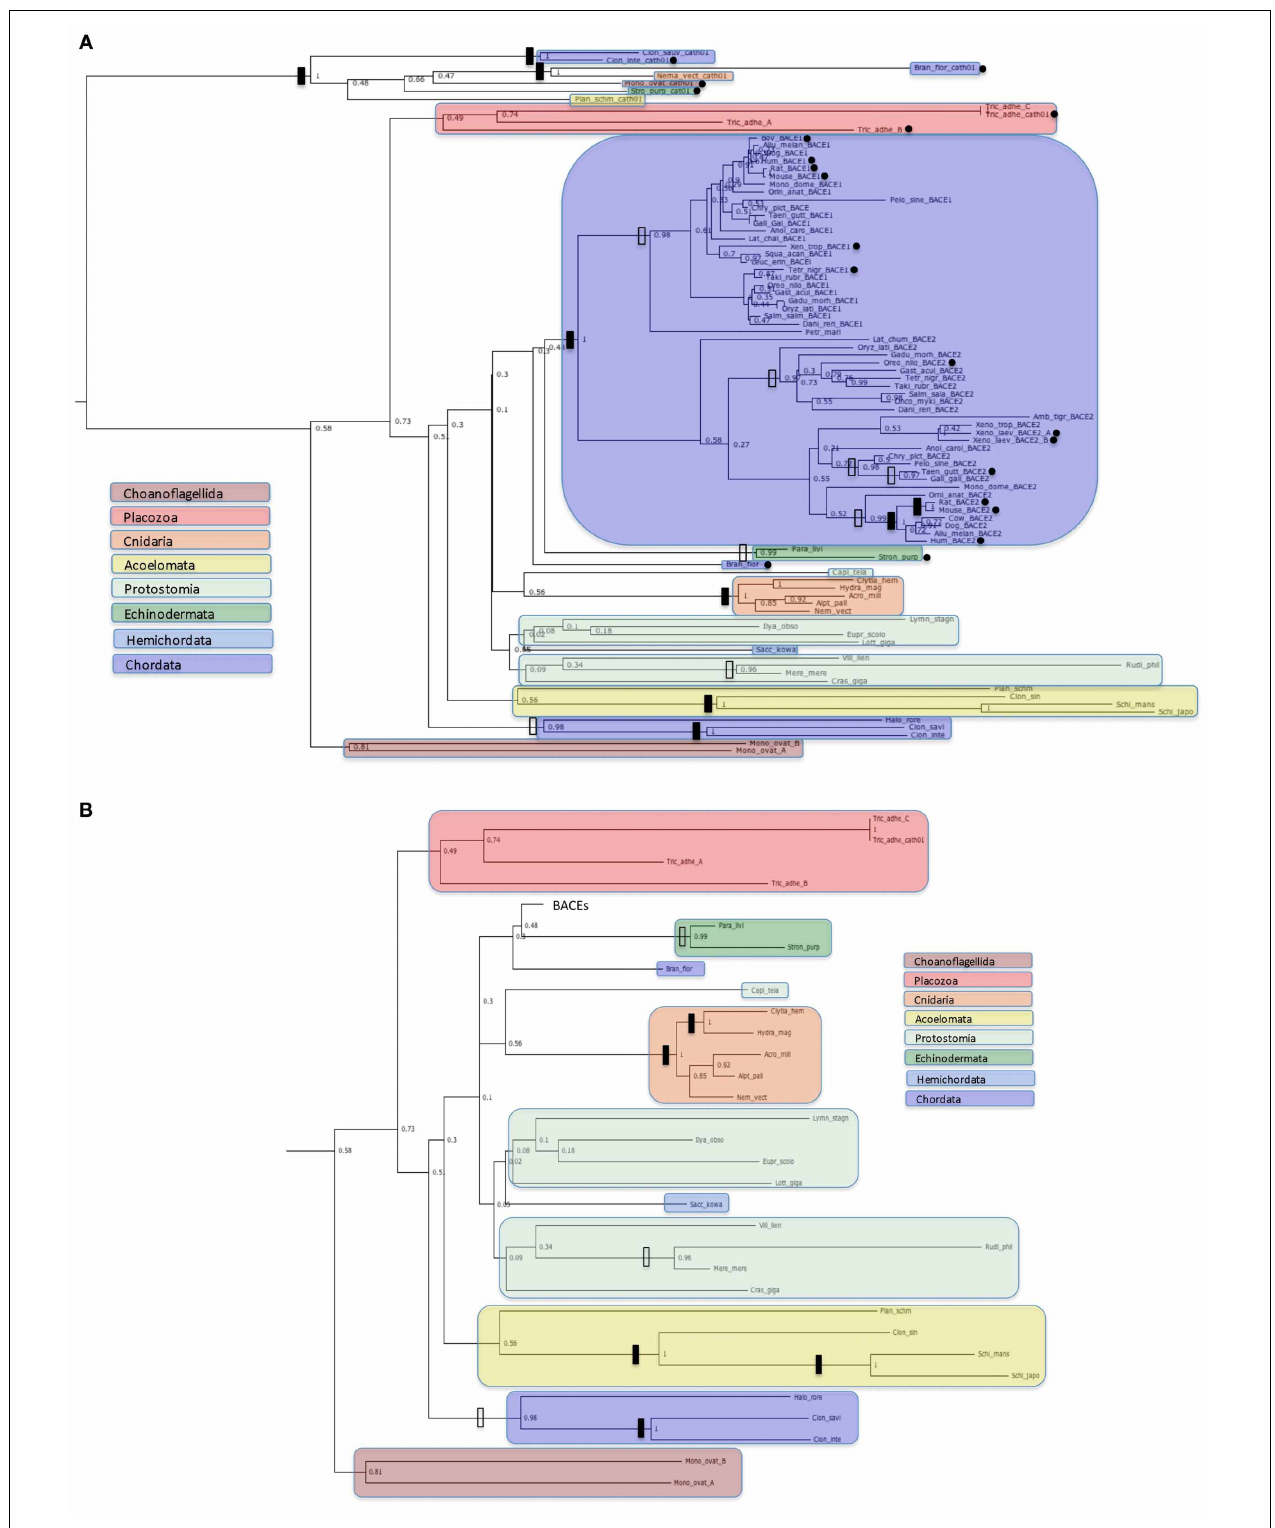
FIGURE 3 | Protein trees of BACE protein sequences. Sequences are labeled as in Table 2 . Black dots indicate sequences with accession numbers for complete ORFs in Table 2 . Solid vertical bars represent bootstrap values of 100% and open bars represent bootstrap values